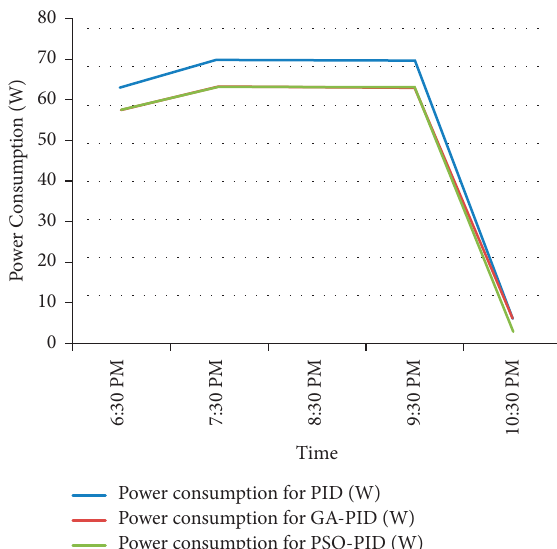
Figure 20: Power consumption for exhaust fan in (W) for PID, GA-PID, and PSO-PID.